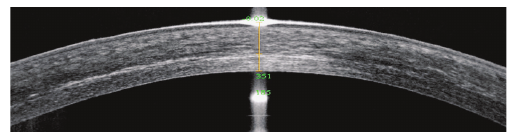
Figure 7: AS-OCT image showing demarcation line at 351 µ m, 2 months after epithelium-on